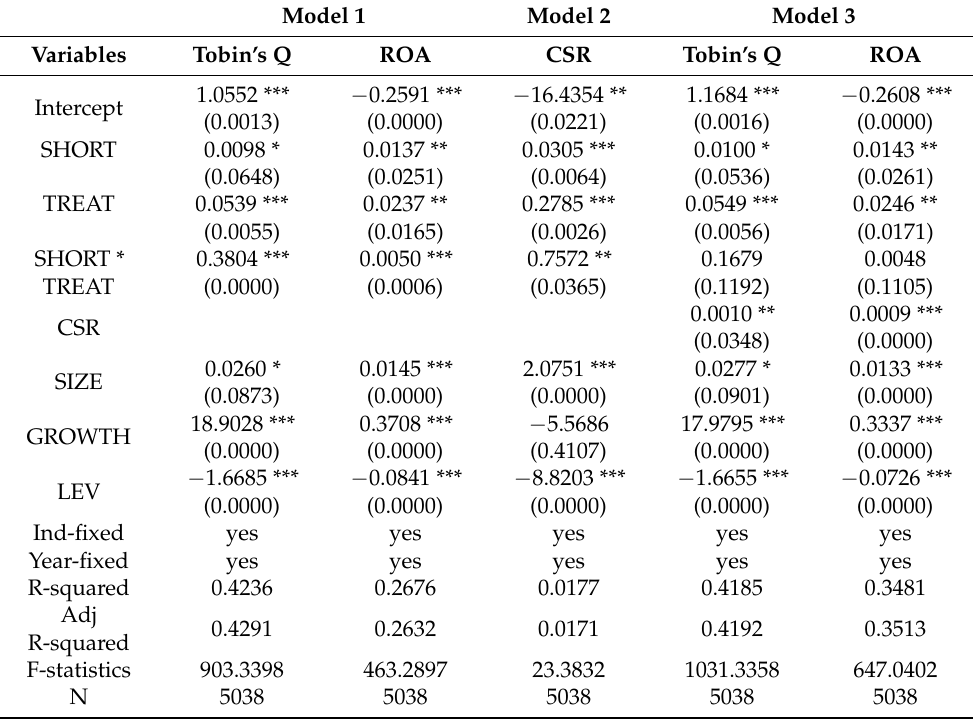
Table 6. Short-selling deregulation, CSR performance and financial